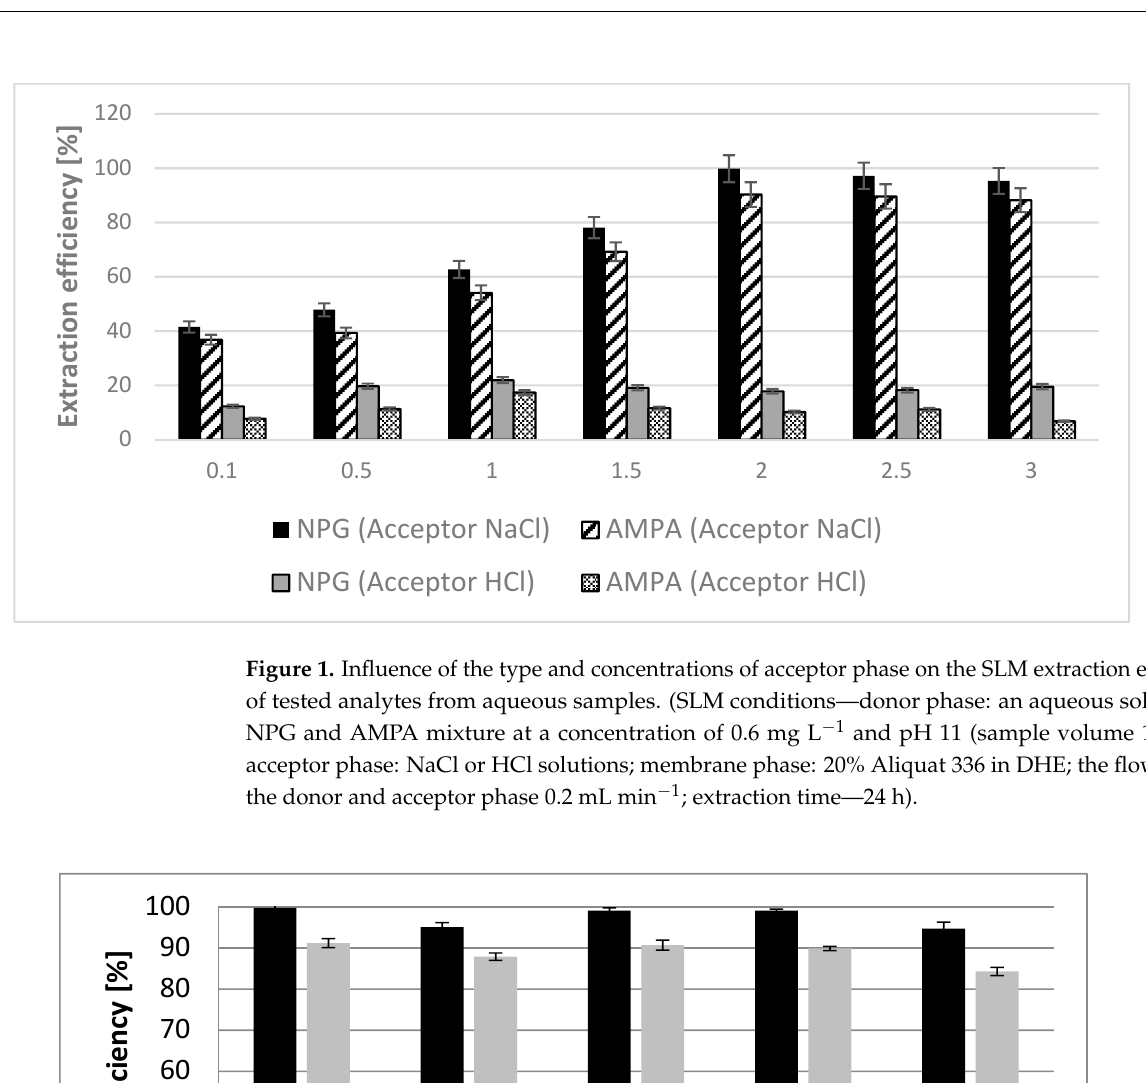
Figure 1. Influence of the type and concentrations of acceptor phase on the SLM extraction efficiency of tested analytes from aqueous samples. (SLM conditions—donor phase: an aqueous solution of NPG and AMPA mixture at a concentration of 0.6 mg L − 1 and pH 11 (sample volume 100 mL); acceptor phase: NaCl or HCl solutions; membrane phase: 20% Aliquat 336 in DHE; the flow rate of the donor and acceptor phase 0.2 mL min − 1 ; extraction time—24 h).